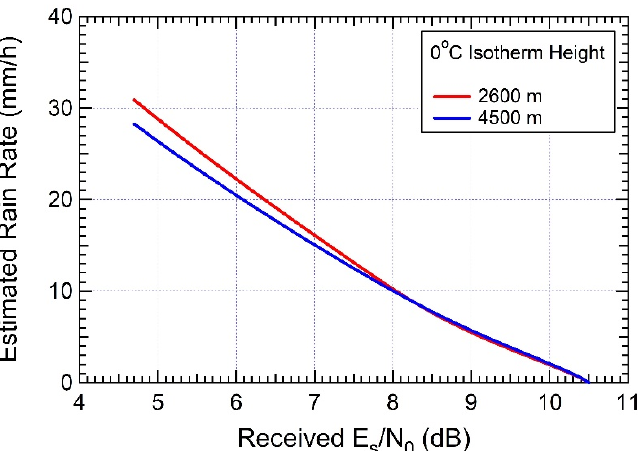
Figure 9. Dynamic range of the RR estimation technique in [8], with 10.5 dB of nominal clear-sky ESNDR and 4.68 dB of minimum required ESNDR (see Table 3).